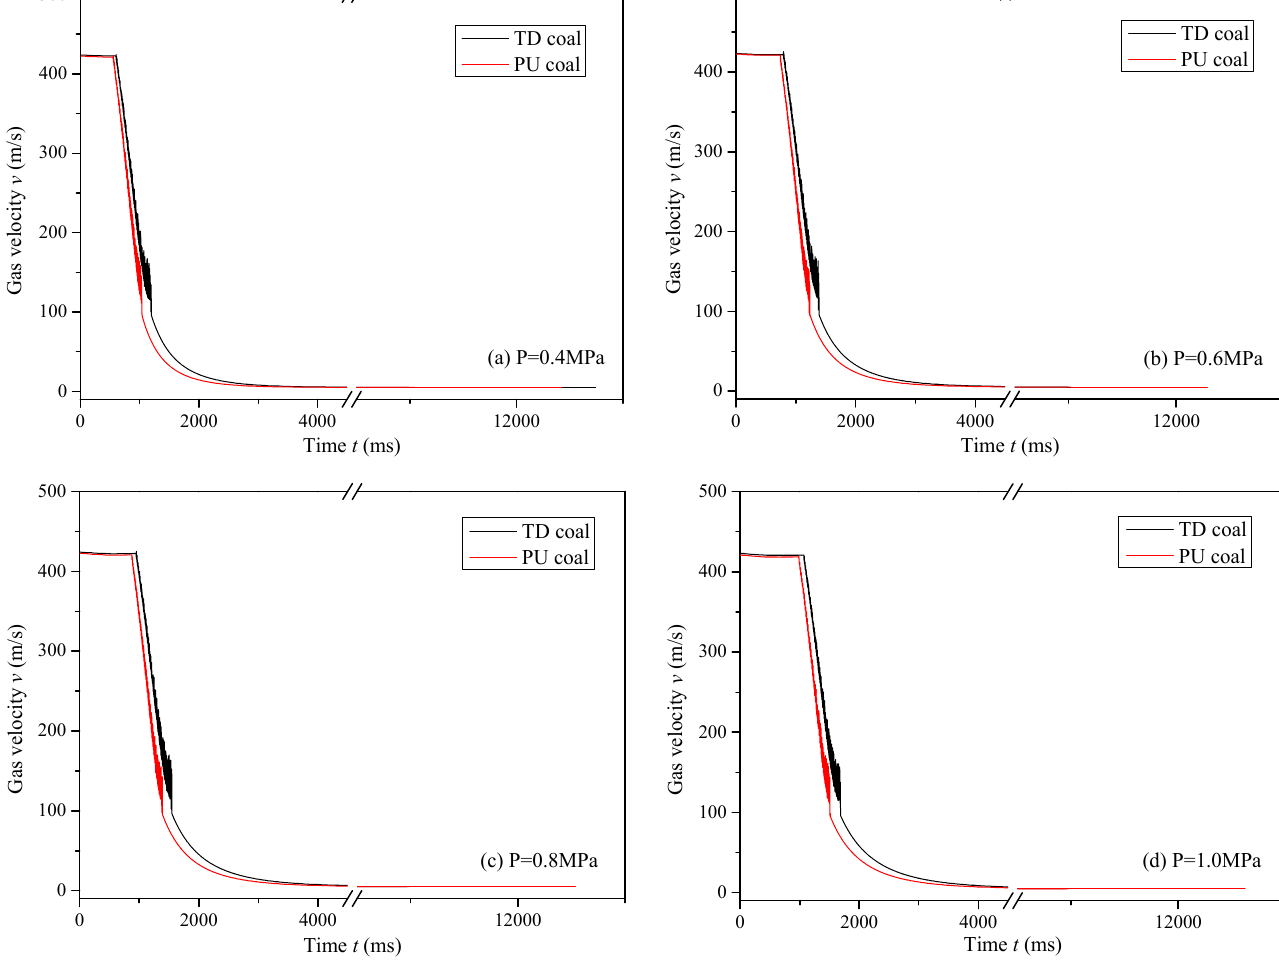
Figure 9. Comparison of gas velocity change vs. time under the same gas pressure between TD coal and PU coal.